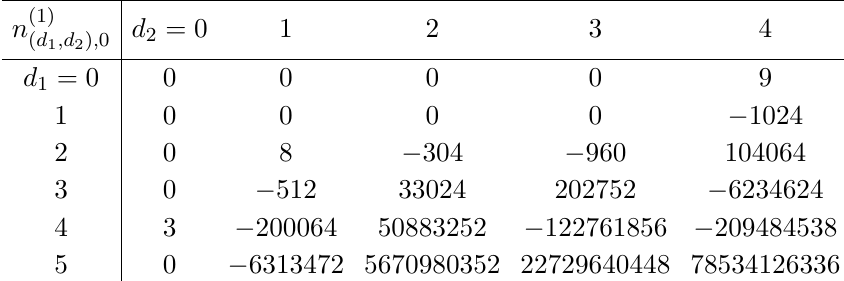
Table 30 . Genus 1 Gopakumar-Vafa invariants for X (4)